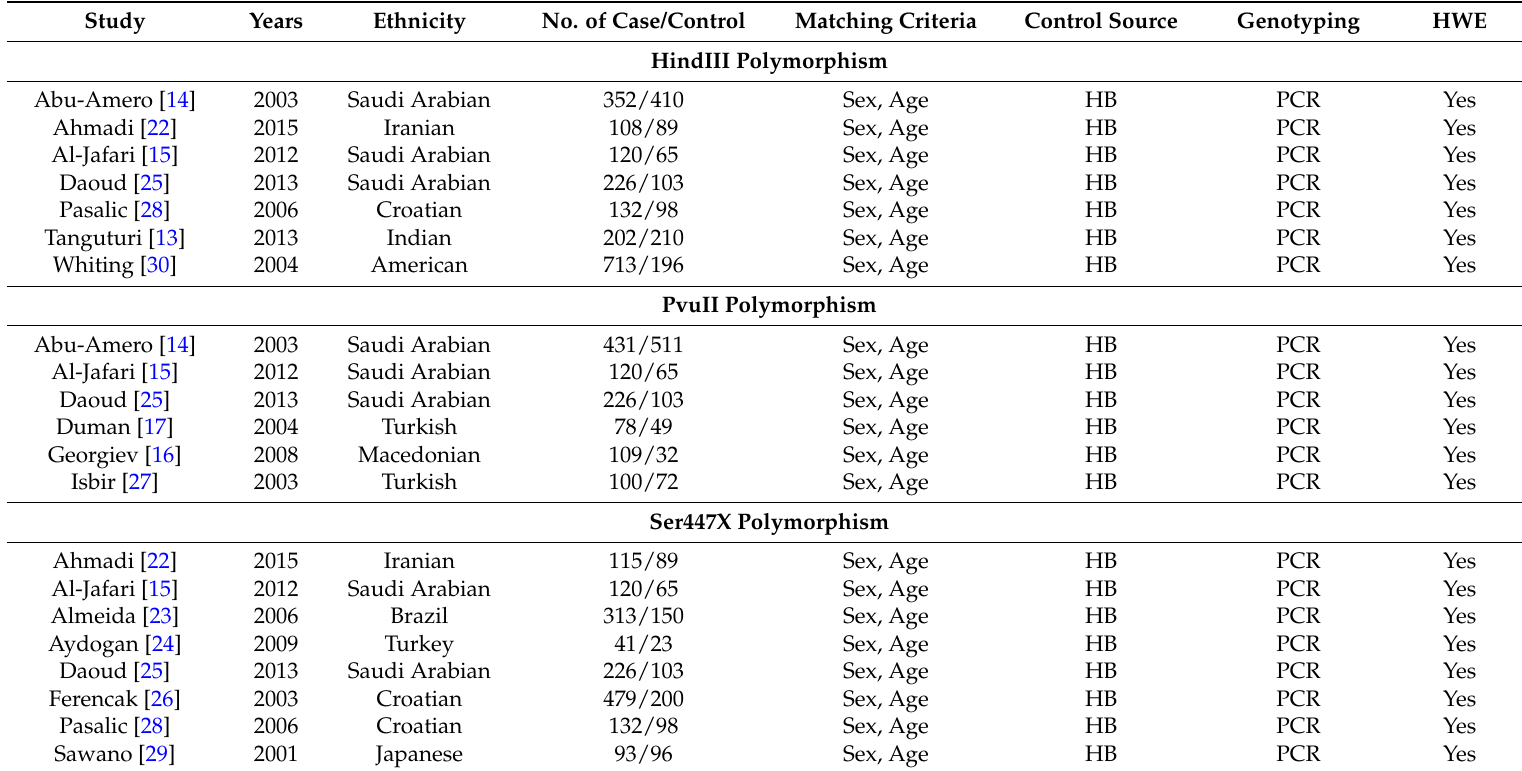
Table 1. Characteristics of studies included in